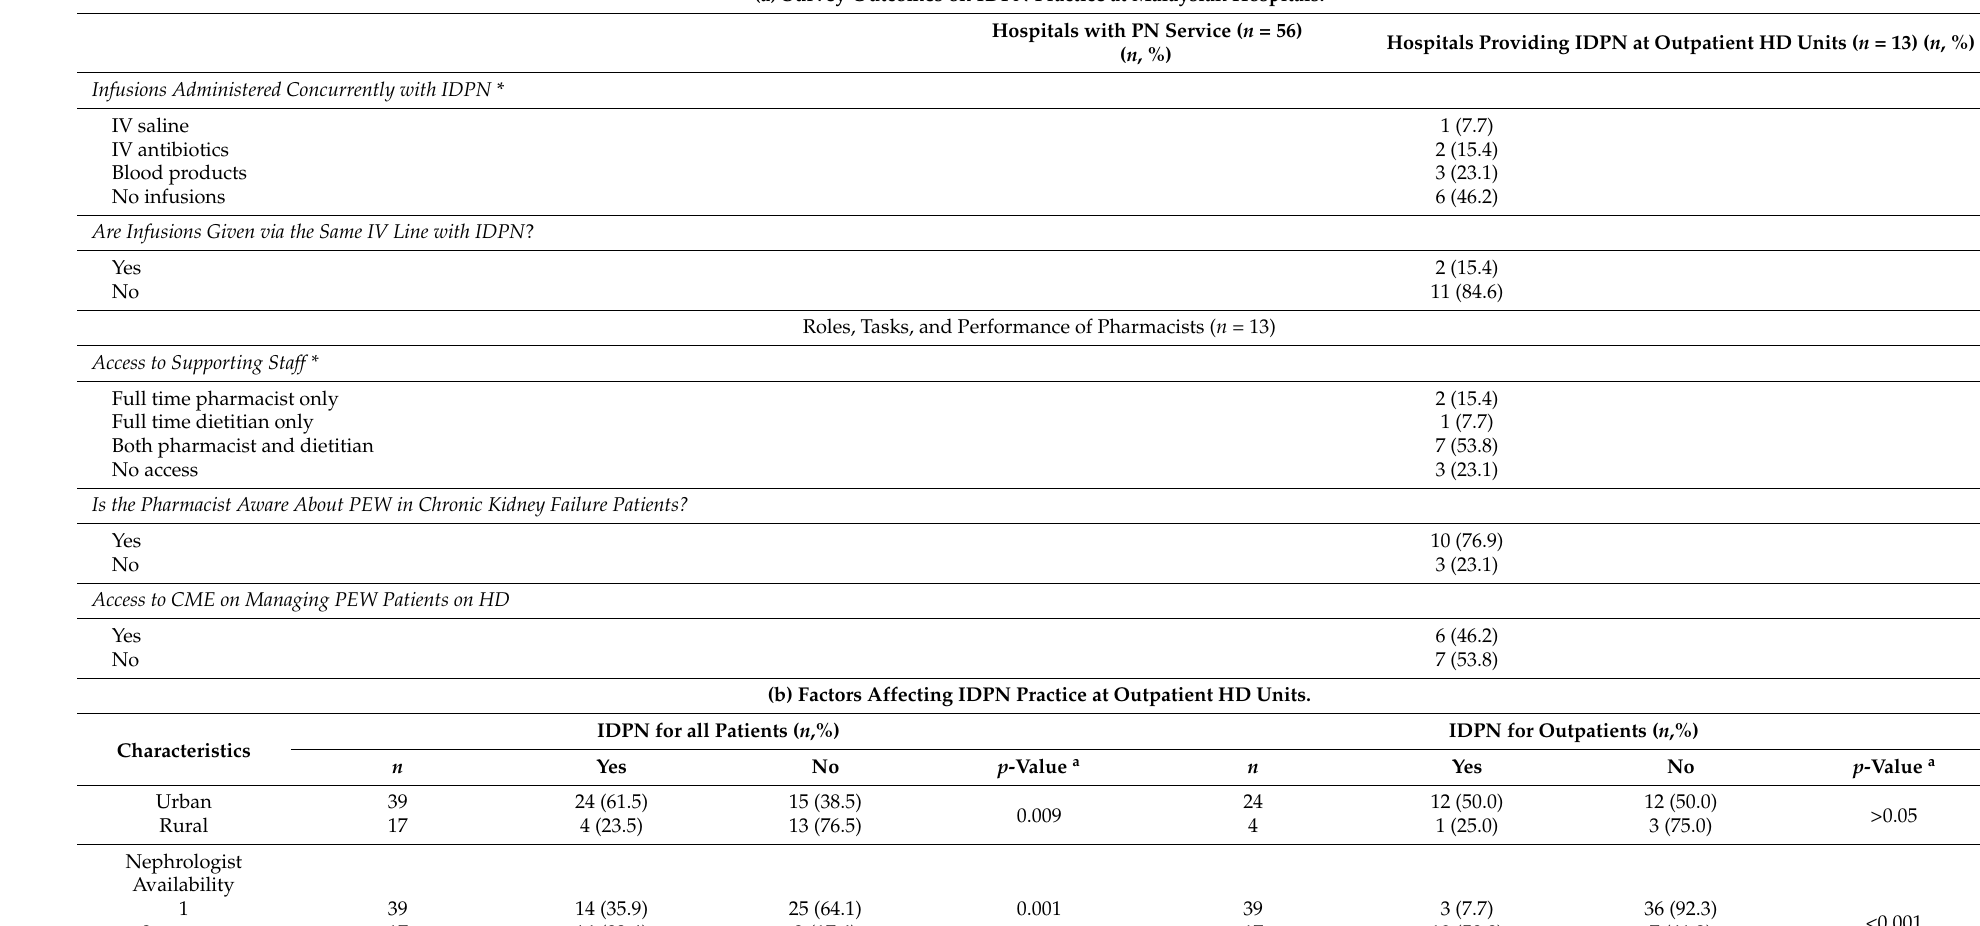
Table 2. Cont . (a) Survey Outcomes on IDPN Practice at Malaysian